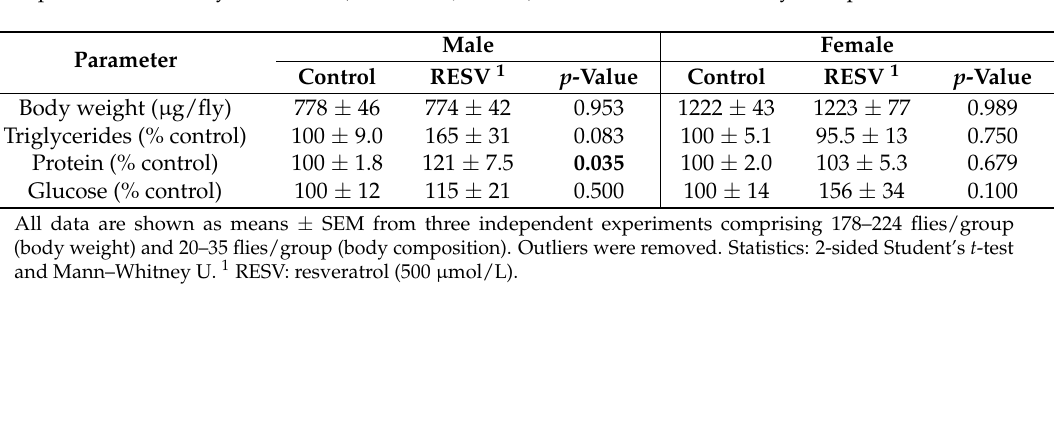
Table 1. Changes in body weight and body composition of male and female w 1118 D. melanogaster